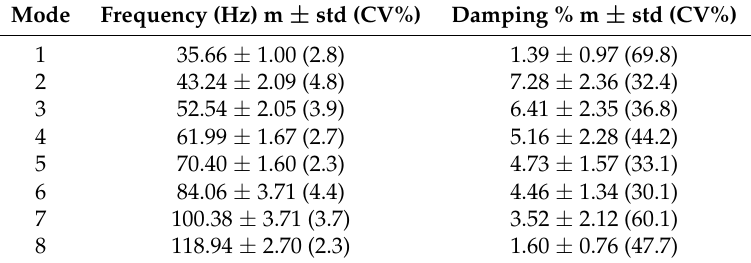
Table 5. Results of the modal identification on eleven subjects (Protocol